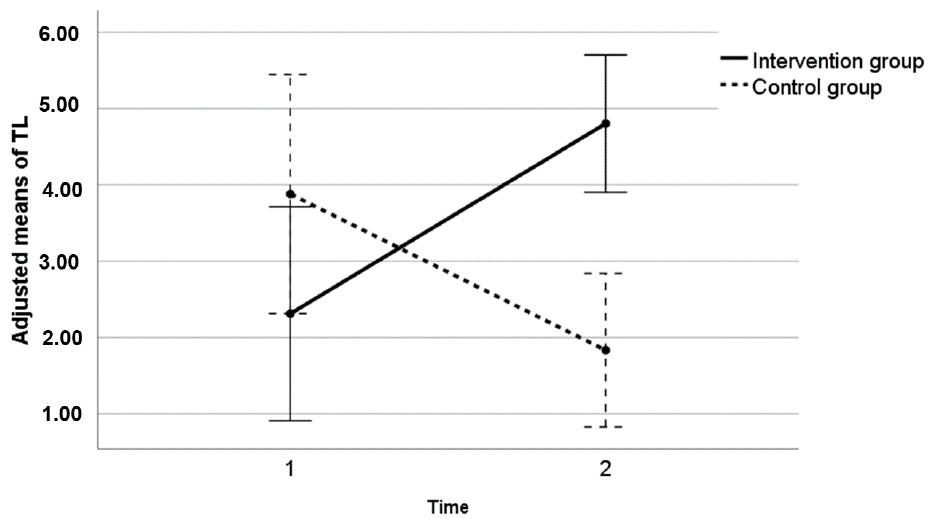
Figure 1. Graph representing the interaction between the experimental groups and time with respect to TL. The points represent the adjusted means by weight change and % fat change. The 95% confidence intervals for the adjusted means are also represented. Time 1: telomere length values at the end of the intervention in both groups. Time 2: telomere length values 6 months after completion of the intervention.